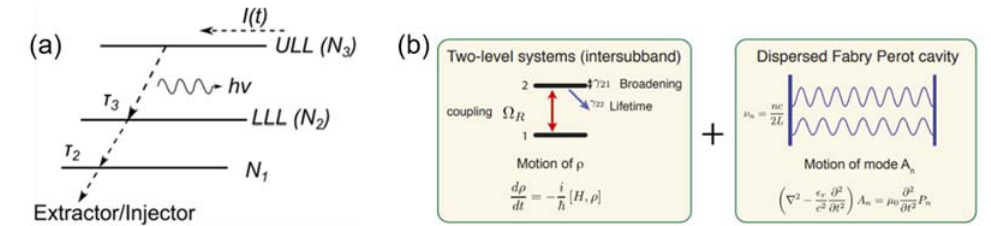
Figure 1. The theoretical models used to study multi-mode dynamics and frequency combs in QCLs: ( a ) the electron transportations in QCLs based on which the reduced rate equation model was developed; ( b ) Maxwell–Bloch Equations that combine the Bloch equation and the wave equation to study optical frequency combs in QCLs. (Figure modified from Ref [47], reprint with the permission of Optica publishing group).